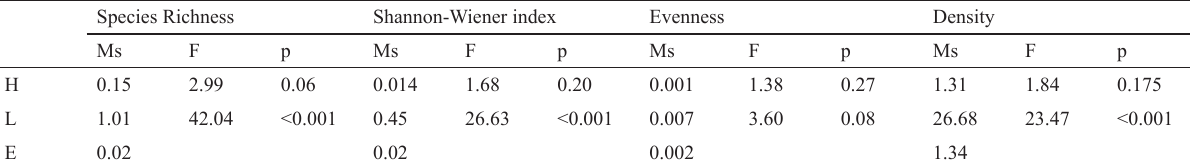
Table 2. Repeated Measures Analysis of Variance results for Species richness, Shannon-Weiner index, Evenness and Density between daily time (H) (9h, 13h, 16h) and local (L) ( No Tourism Vs. Tourism sites). E -